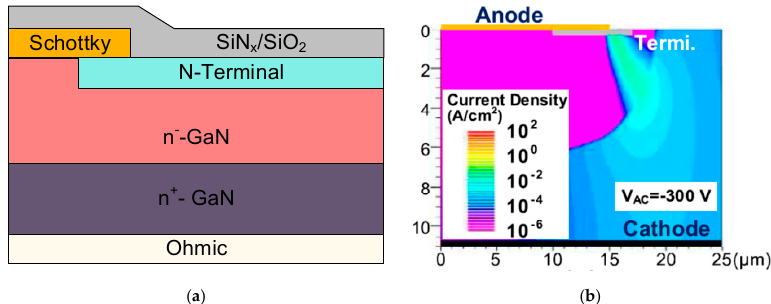
Figure 9. ( a ) Schematic cross-section of the vertical GaN NT-SBD and ( b ) simulated leakage current distribution of NT-SBD at − 300 V.